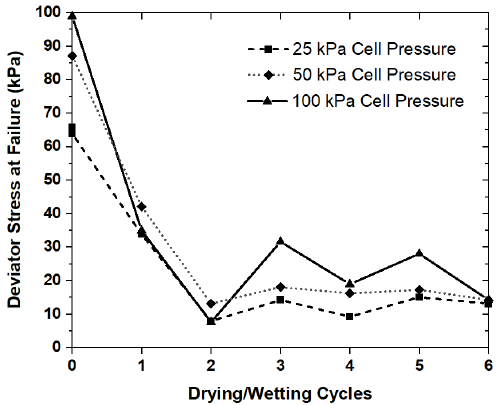
Figure 11. Relationship between deviator stress at failure and drying/wetting cycles (drying limit 15% water content and wetting to 22% water content) for a compacted sandy clay derived from the Durham Lower Boulder Clay, tested at different confining pressure levels (modified after Stirling, et al. [19] ).